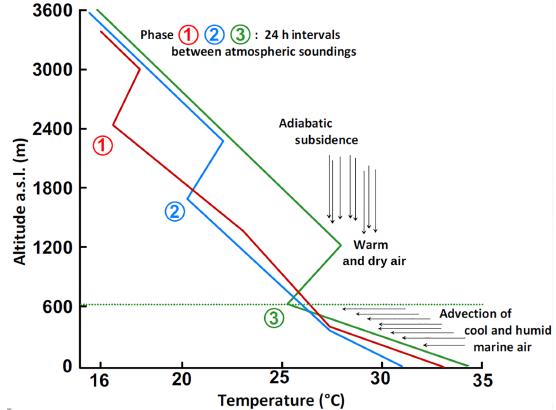
Figure 9. Successive schematic sounding thermal profiles indicat- ing the downward motion of adiabatic subsidence accompanied by a weakening of the Persian Trough, which restricts the mixing layer depth to shallow layer of the atmosphere (phases 1–3 are 24h in- tervals between each sounding at Beit Dagan, Israel) (from Dayan et al., 1988; ©American Meteorological Society; used with permis-